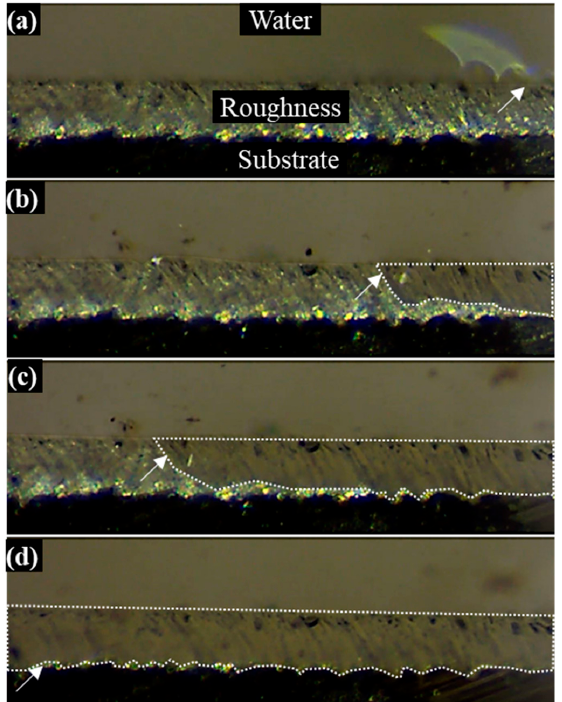
Figure 7. ( a – d ) The time progression of the liquid layer in snow (LWC ~22%) infiltrating the surface roughness (RMS = 36.4 μ m) of Al 6061 substrate at a substrate temperature of 2 ° C: ( a ) Water is above the surface roughness. ( b ) As time progresses, the water begins to seep into the roughness, shown with a dashed white line. ( c ) Water continues to flow into the surface roughness until ( d ) the roughness